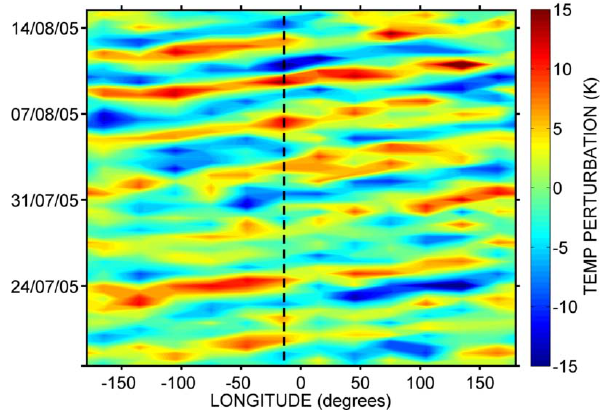
Fig. 6. Hovm¨oller diagram of Aura MLS temperatures with daily longitudinal means subtracted for 17 July to 15 August 2005 at a height of 97km. The dashed line represents the longitude of Ascen- sion Island.